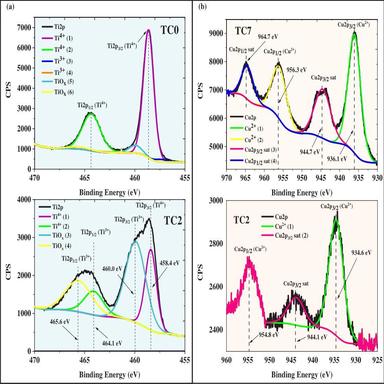
Deconvolution curves from high resolution-XPS spectra: (a) Ti2p for TC0 and TC2; (b) Cu2p for TC7 and TC2.